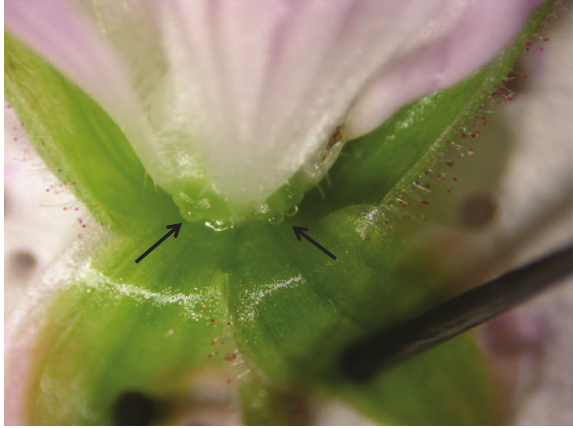
Figure 2. Position of the nectaries in a G. sylvaticum flower. Arrows show nectar droplets.